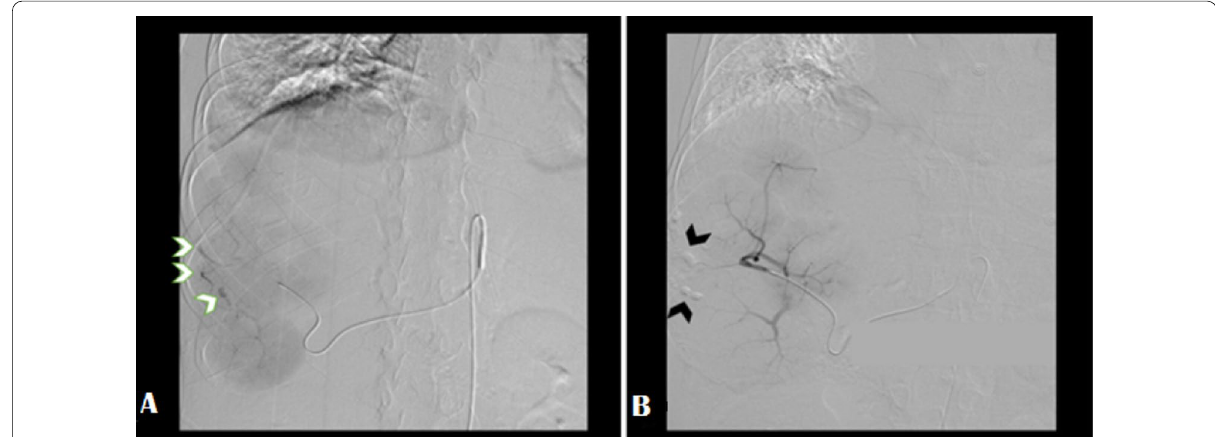
Fig. 3 Digital subtraction angiogram of the splenic artery. A Splenic artery run showing small foci of abnormal vascular blush (white arrowheads) in right upper quadrant along splenic artery small branches. These bleeding branches were embolized using Gelfoam embolic. B Post-embolization run shows no residual abnormal vascular blush. Faintly visualized deposited Gelfoam can be seen in those areas (black